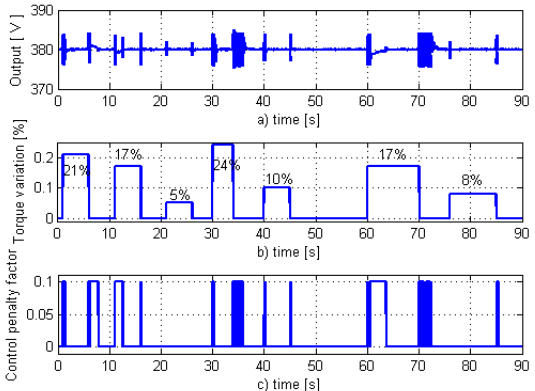
Figure 8. Robustness test—mechanical torque variation: ( a ) controlled output (terminal voltage); ( b ) mechanical torque variation (disturbance); ( c ) variable setting of control penalty factor.